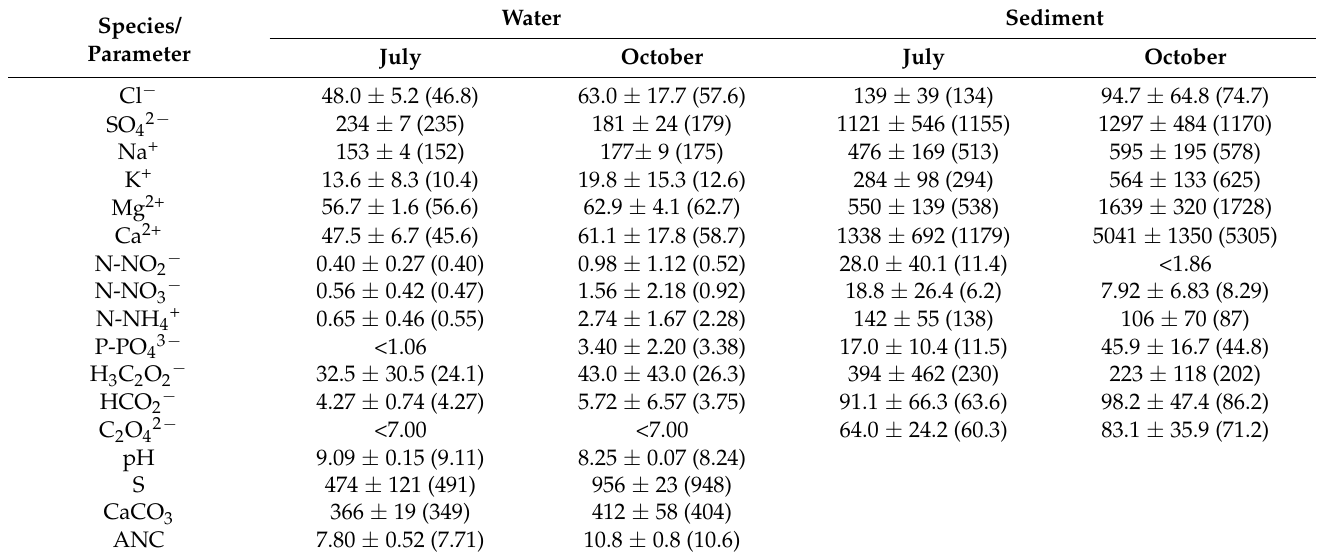
Table 1. Water-soluble ions concentrations in water (mg L − 1 ) samples (n = 44), pH, conductivity (S, µ S cm − 1 ), acid- neutralizing capacity (ANC, meq L − 1 ), and hardness (in mg L − 1 CaCO 3 ) and water-soluble ions concentrations in sediment ( µ g g − 1 ) samples (n = 14) from Podu Iloaiei Dam Lake, north-eastern Romania. Data are presented as mean ± stdev (median) for the entire pool of analyzed samples (no flagged